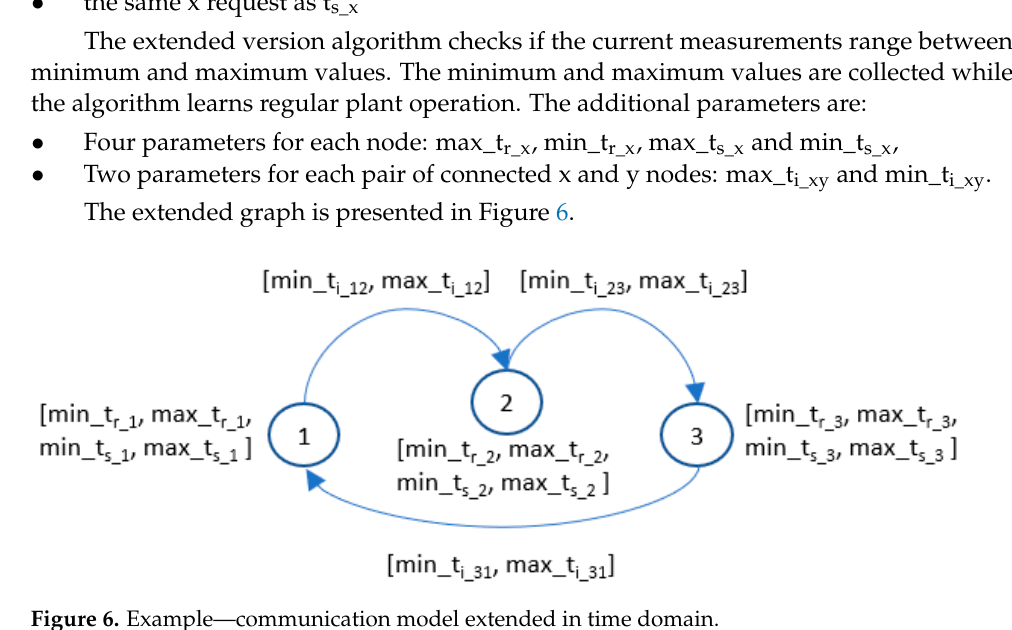
Figure 6. Example—communication model extended in time domain.